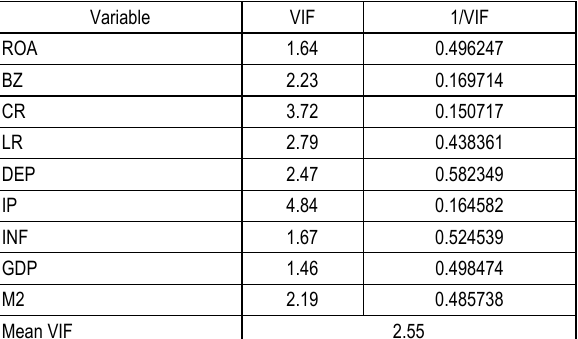
Table 5. Variance inflation factor, VIF